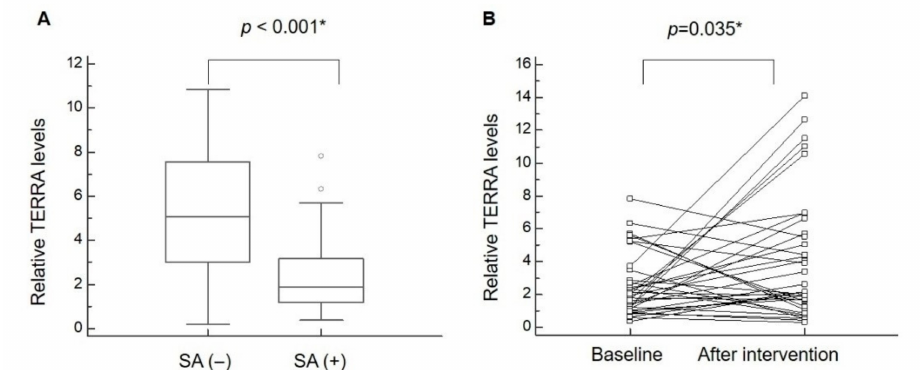
Figure 3. TERRA expression in leukocytes increases after exercise and nutrition intervention in participants with sarcopenia. ( A ) The expression of telomeric repeat–containing RNA (TERRA) between participants with and without sarcopenia (SA). ( B ) The expression of TERRA at baseline and after exercise combined with nutrition intervention. * denotes p <